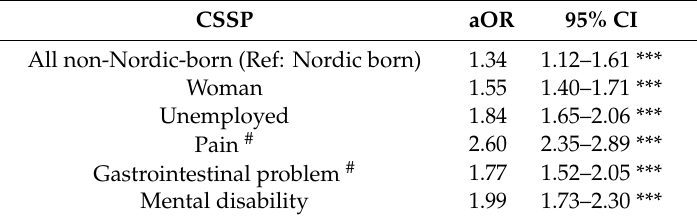
Table 2. Adjusted odds ratios (aOR) for CSSP, with 95% confidence intervals (95% CI). CSSP aOR